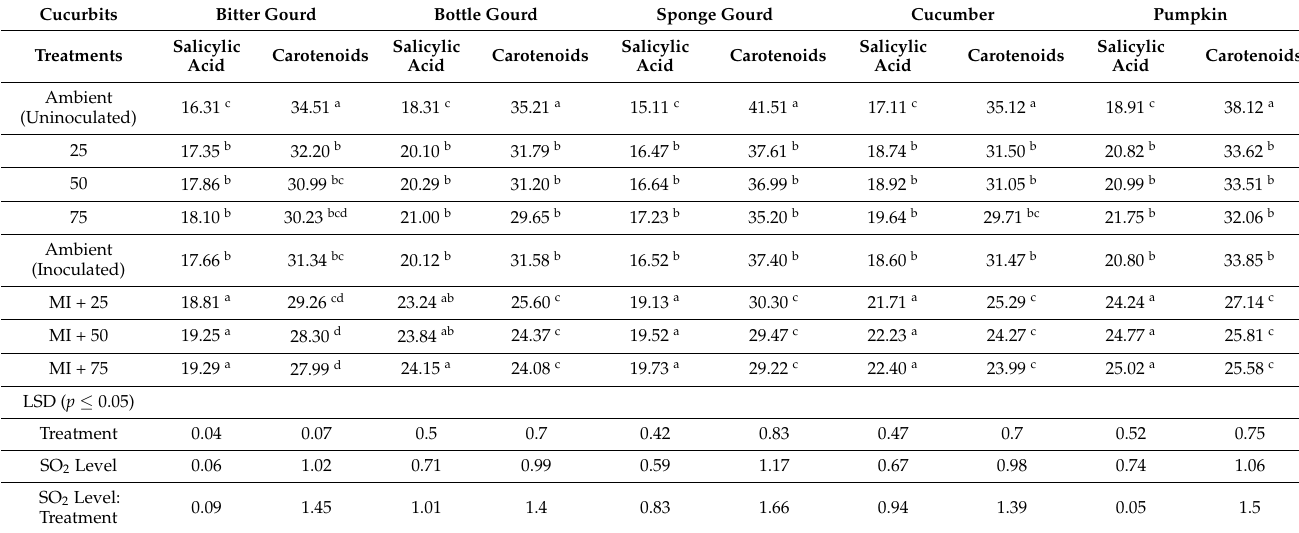
Table 4. Effect of intermittent exposures of SO 2 (ambient, 25, 50 and 75 ppb) and root-knot disease on salicylic acid content and carotenoids in five cucurbits.